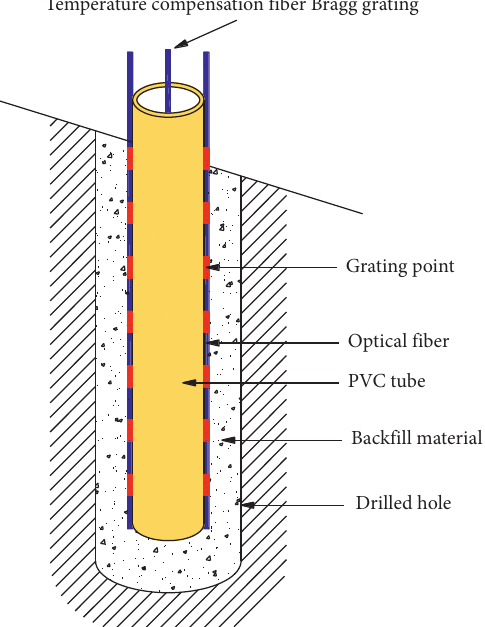
Figure 8: Schematic diagram of the equipment installation for the monitoring of landslide internal deformation using fiber grating.